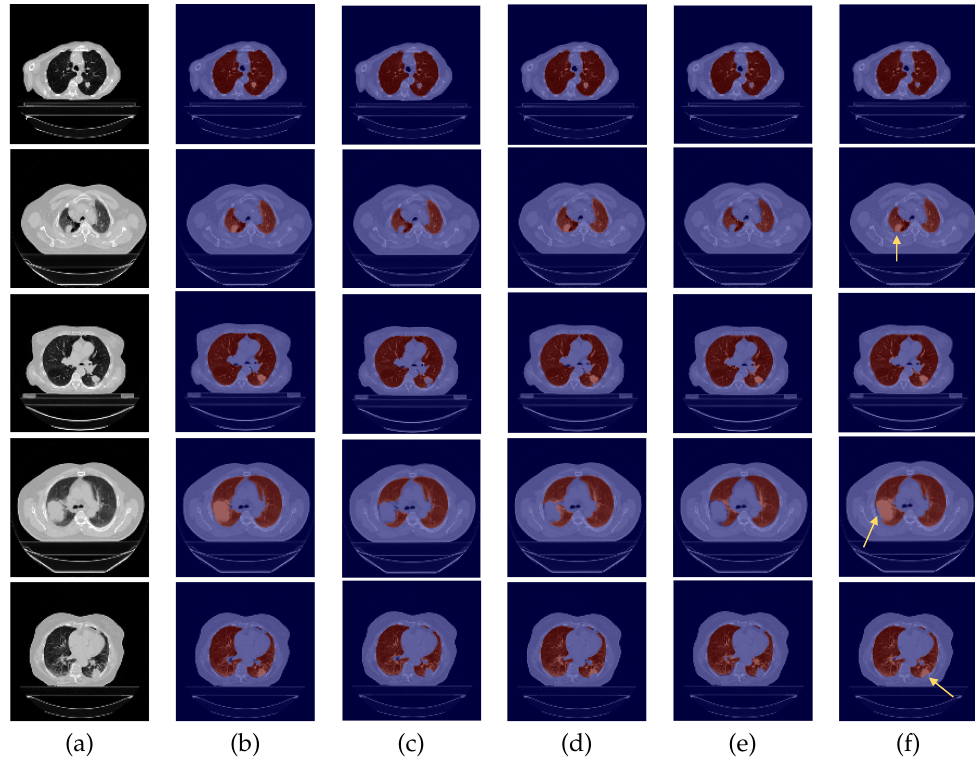
Figure 5. Examples of 24-LCTSC scans. From left to right: ( a ) CT original image; ( b ) ground-truth (G-T); ( c ) baseline prediction; ( d ) #2 with DC and without DA predicted mask; ( e ) #3 with DA and without DC predicted mask; ( f ) and #4 with DA and DC predicted mask.